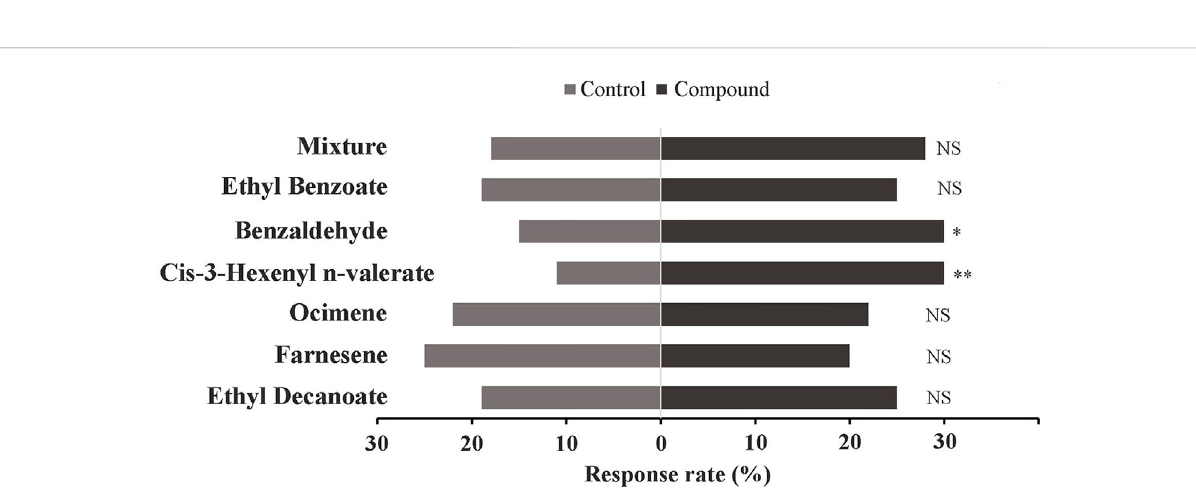
Response of E. onukii to 10 μ g/ μ L compounds. Asterisks indicate signi fi cant differences; * p < 0.05, and ** p < 0.01. NS indicates no signi fi cant difference ( χ 2 test). Two compounds, Benzaldehyde (chi-square: 5; p value: 0.026) and Cis-3-Hexenyl n-valerate (chi-square: 8.8; p value: 0.003), showed signi fi cant differences in this